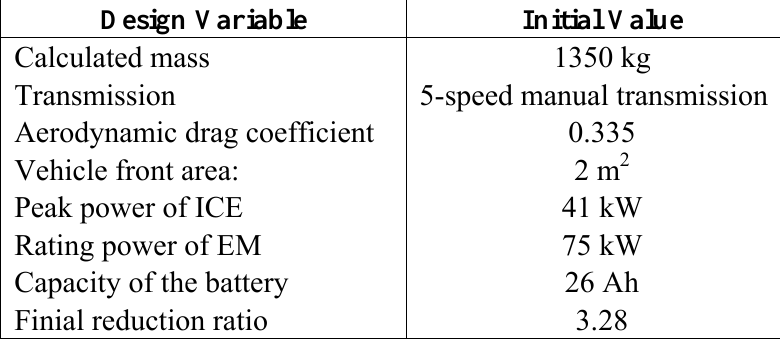
Table 3. Initial powertrain value of design variables.